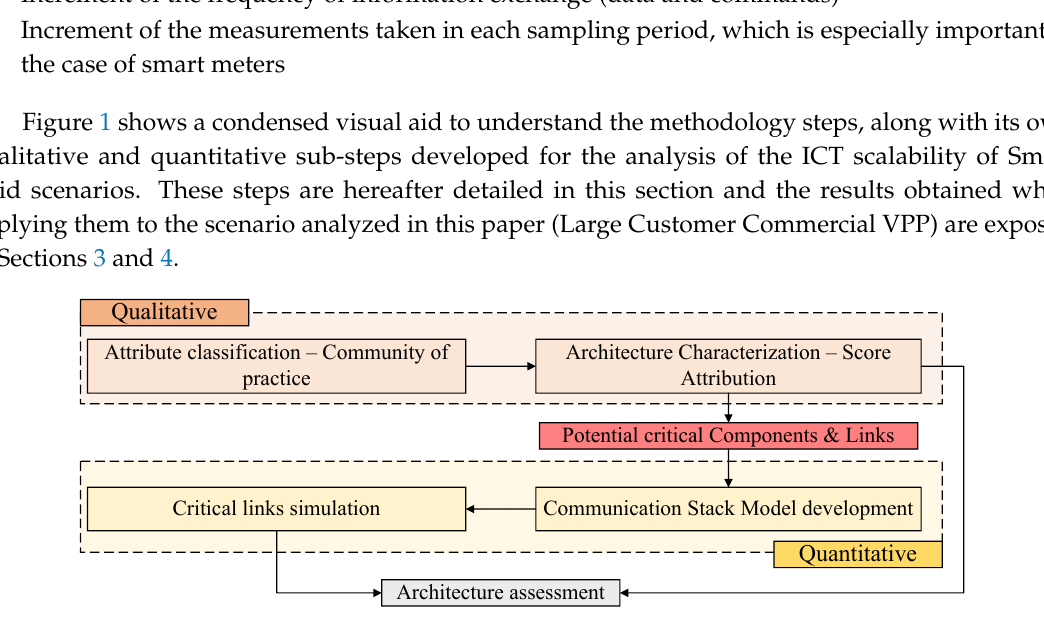
Figure 1. Overview of the proposed two-step methodology for the assessment of the scalability of Information and Communication Technology (ICT) infrastructures for Smart